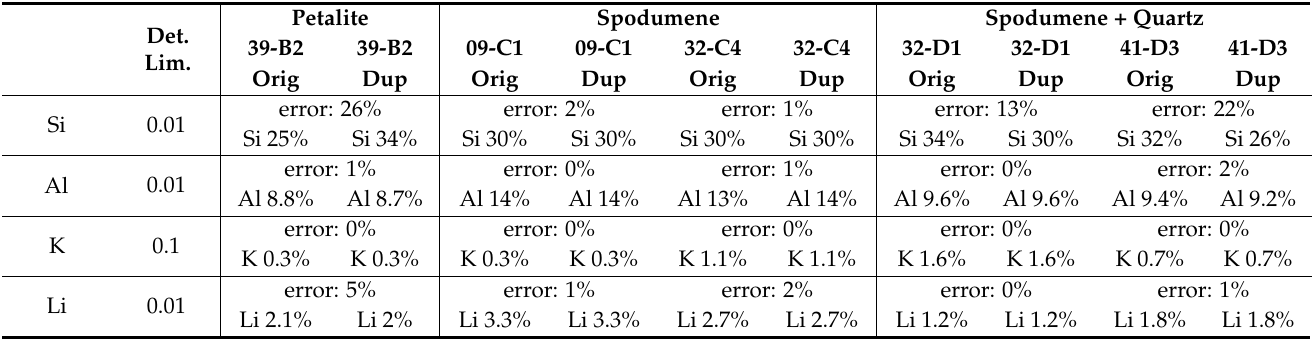
Table 4. ICP-MS errors from the duplicates made in Actlabs for the major elements of petalite, spodumene and quartz with the method FUS-Na 2 O 2 .